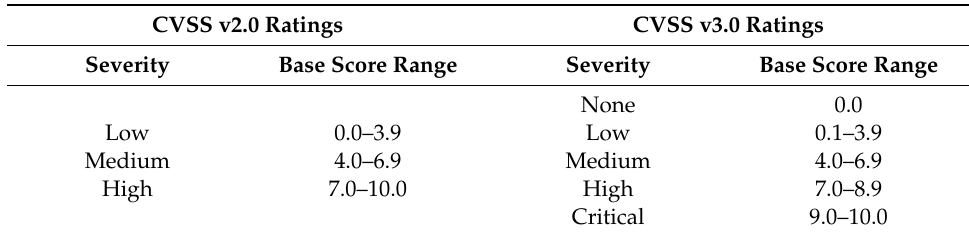
Table 8. Calculation of the severity ratings based on the CVSS scores, according to